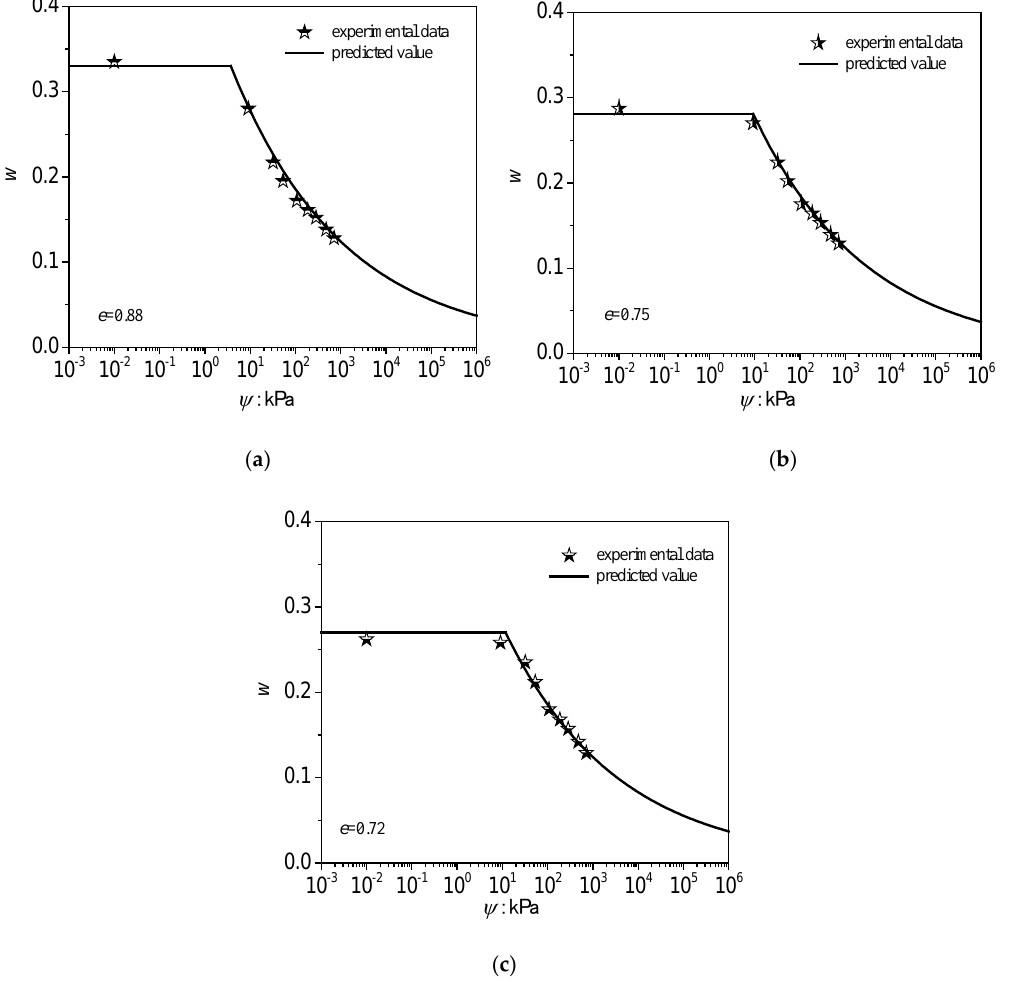
Figure 20. Measured and predicted SWCCs for Xi’an loess specimens at deformed state at ( a ) e = 0.88; ( b ) e = 0.75; ( c ) e = 0.72 (data after Wang et al. [44]).